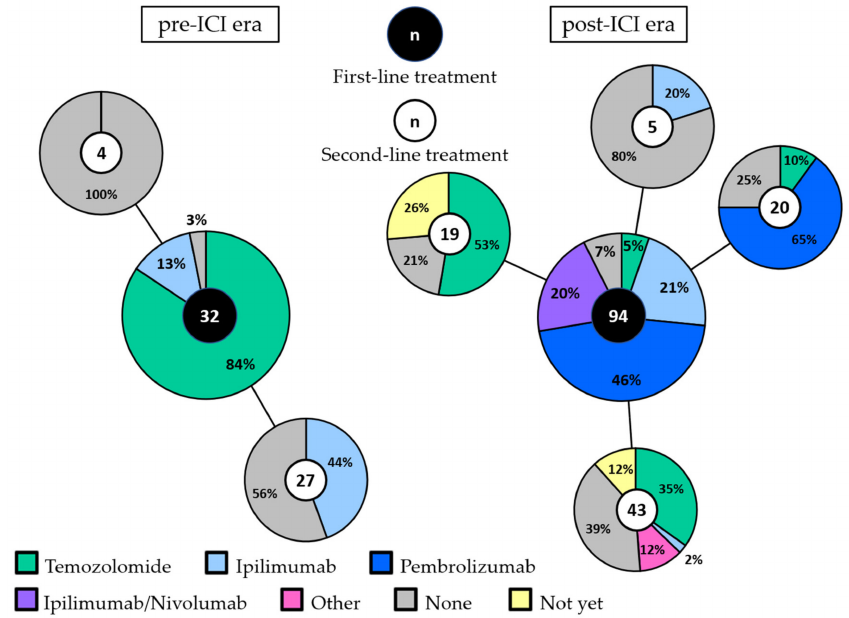
Figure 1. First-line and second-line treatment in the pre-ICI and post-ICI era. The large pie charts represent the first-line treatment in the pre-ICI era (left) and the post-ICI era (right). Second-line treatment is shown per first-line treatment in the connected smaller pie charts. The total number of patients in each pie chart is depicted in the middle. Patients that are still alive, either with ongoing partial response or stable disease to first-line treatment or with progression but did not receive second-line treatment yet, are depicted in yellow (“not yet”). Abbreviations: ICI, immune checkpoint inhibitor.